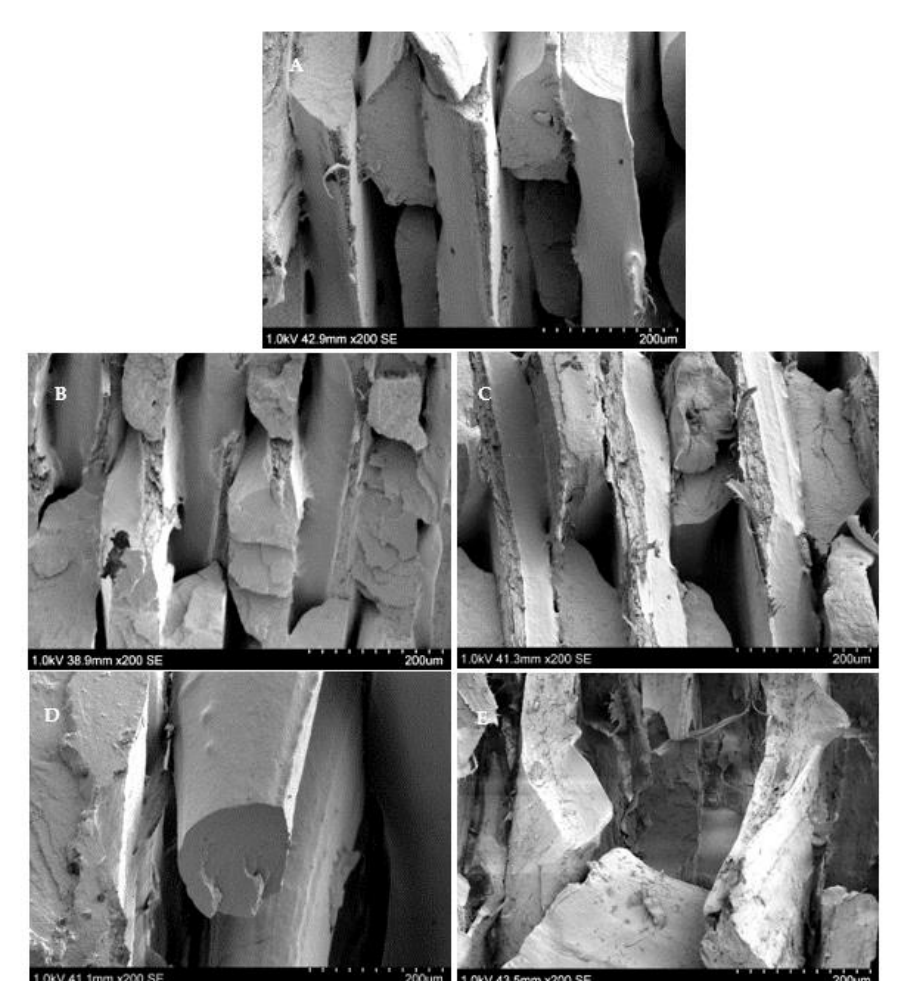
Figure 7. SEM micrographs of tensile test 3D printed test specimen fractured surfaces: ( A ) Denotes PHB (55%)/PLA (45%); ( B ) Denotes PHB (55%)/PLA (45%) + 2 wt.% CC; ( C ) Denotes PHB (55%)/PLA (45%) + 4 wt.% CC; ( D ) Denotes PHB (55%)/PLA (45%) + 6 wt.% CC; ( E ) Denotes PHB (55%)/PLA (4 5%) + 8 wt.%